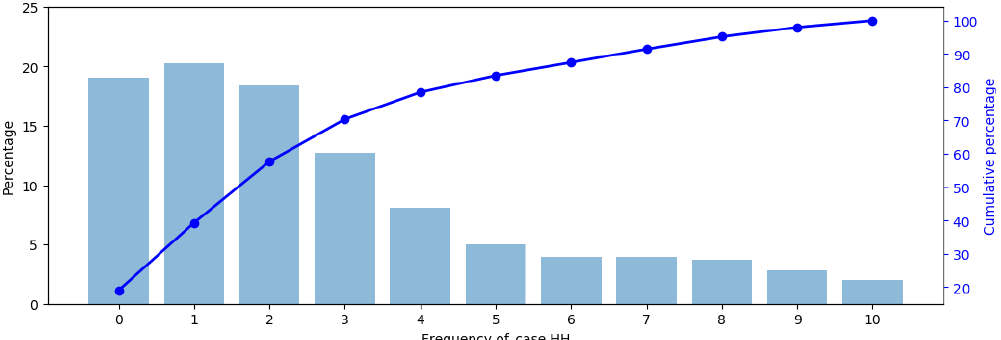
Figure 5. Percentage (bar plot) and cumulative percentage (line plot) of the frequency of case HH under the 10 sets of GCM forecasts of the total precipitation in